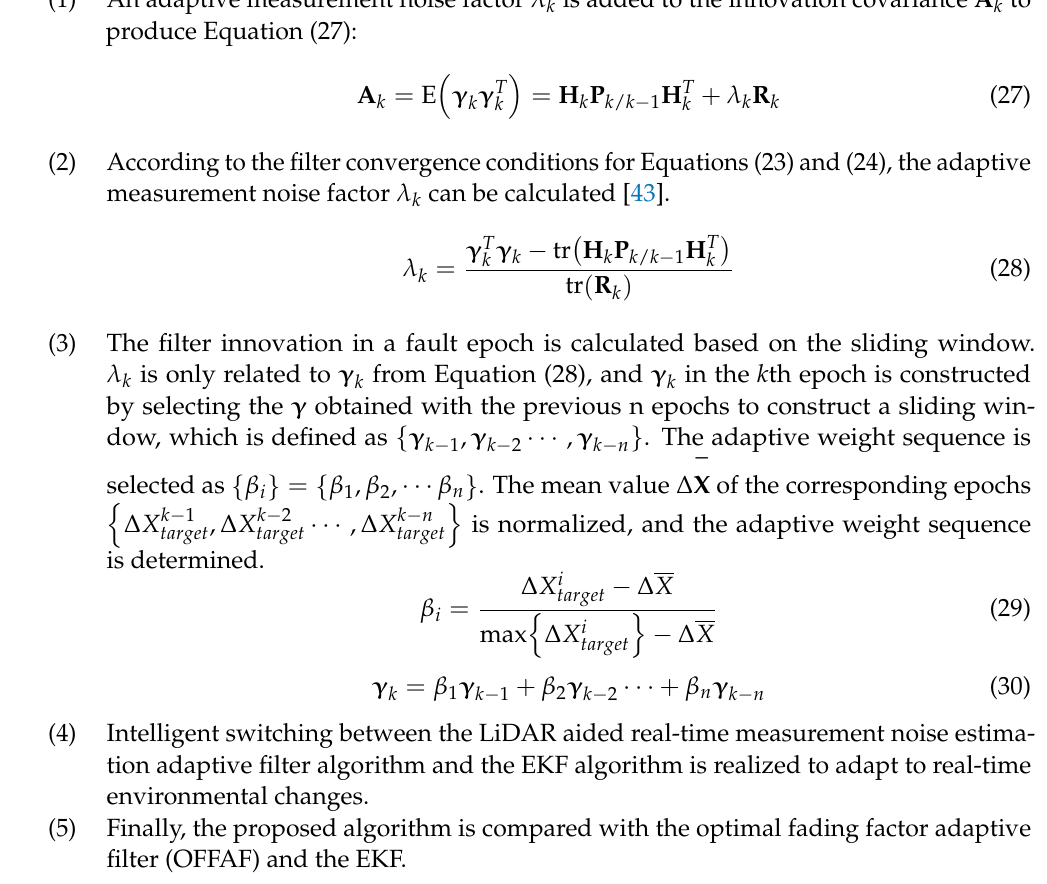
According to the filter convergence conditions for Equations (23) and (24), the adaptive measurement noise factor λ k can be calculated [43].